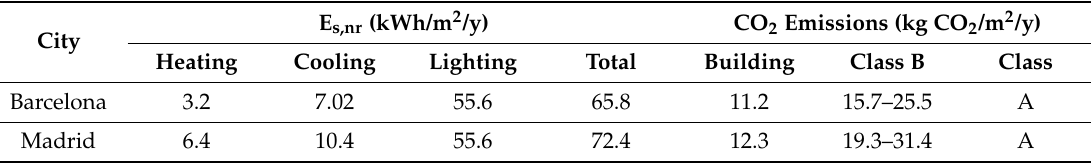
Table 4. Primary energy consumption, CO 2 emissions and building energy classification. City